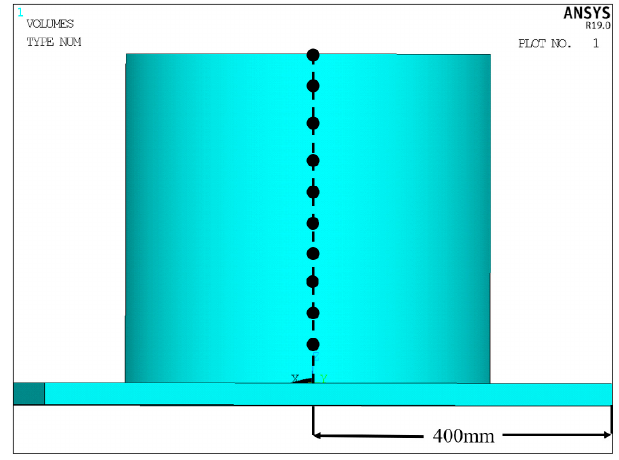
Figure 10. Schematic diagram of node selection along the vertical of the riser.